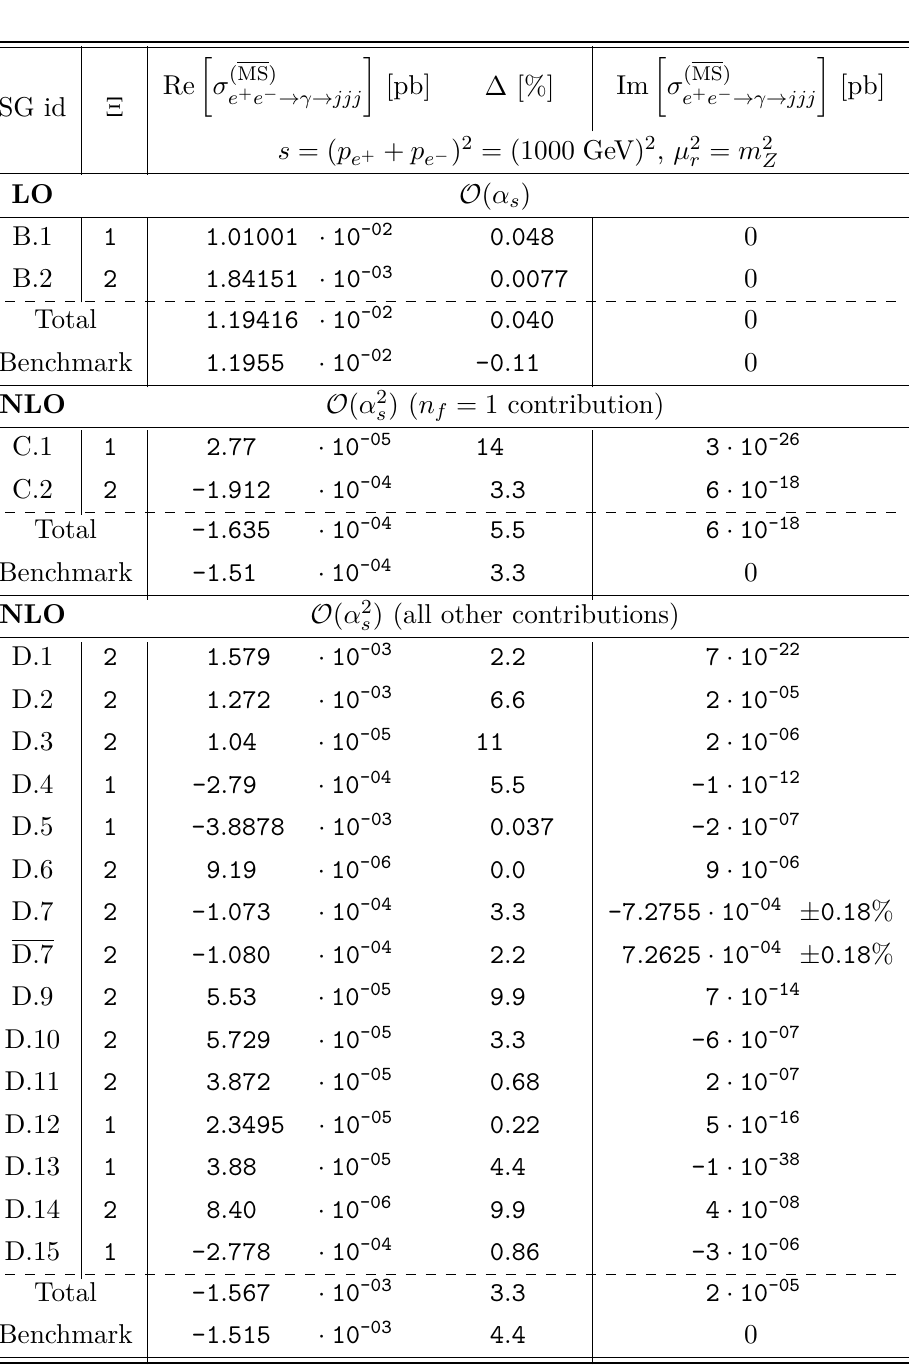
Table 5. Contributions from individual supergraphs listed in table 12 (external current e + e − → γ is not shown there) to the semi-inclusive cross-section up to order O ( α 2 ) (LO+NLO) for the s processes e + e − → γ → jjj with n = 1 and Q = 1 / 3 and SM parameters as given in table. 1 and f q the fiducial cuts discussed in eq. (6.4). Ξ denotes the symmetry factor of the supergraph (included in the result reported). ∆ reports the relative Monte-Carlo error, except for the “Benchmark” entry where it refers to the relative difference w.r.t. the LU result instead. The benchmark results are obtained in this case with MG5aMC [99] and are themselves subject to a 1% MC